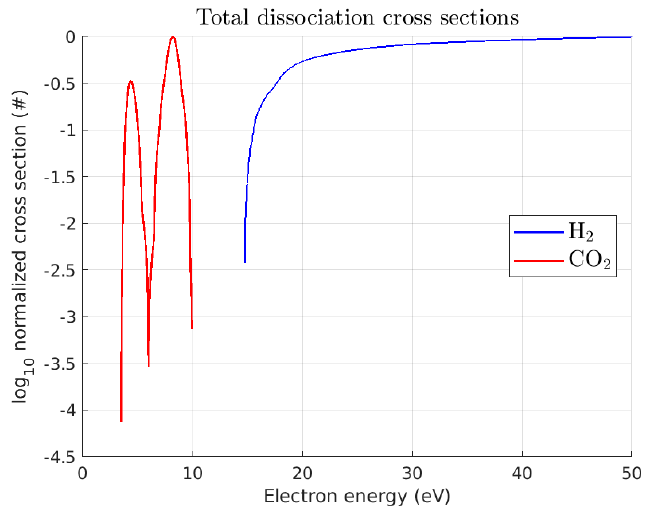
Figure 8. Log10 normalized total dissociation cross section for CO 2 and H 2 .